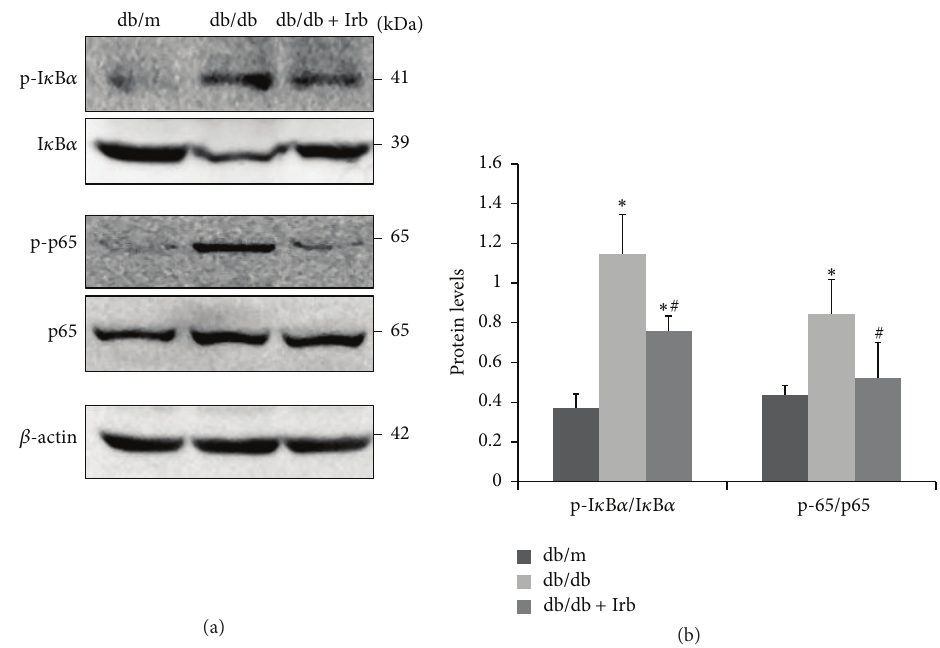
Figure 6: Irb inhibited NF- 𝜅 B pathway activation in db/db mice. (a) Representative immunoblot of p-I 𝜅 B 𝛼 , I 𝜅 B 𝛼 , p-p65, and p65 in the kidney. (b) Quantification of the immunoblot: the ratio between p-I 𝜅 B 𝛼 and I 𝜅 B 𝛼 and the ratio between p-p65 and p65 are presented. The bars in panel (b) show the mean expression in arbitrary units (error bars, S.D.). ∗ 𝑃 < 0.05 compared with db/m; # 𝑃 < 0.05 compared with db/db, 𝑡